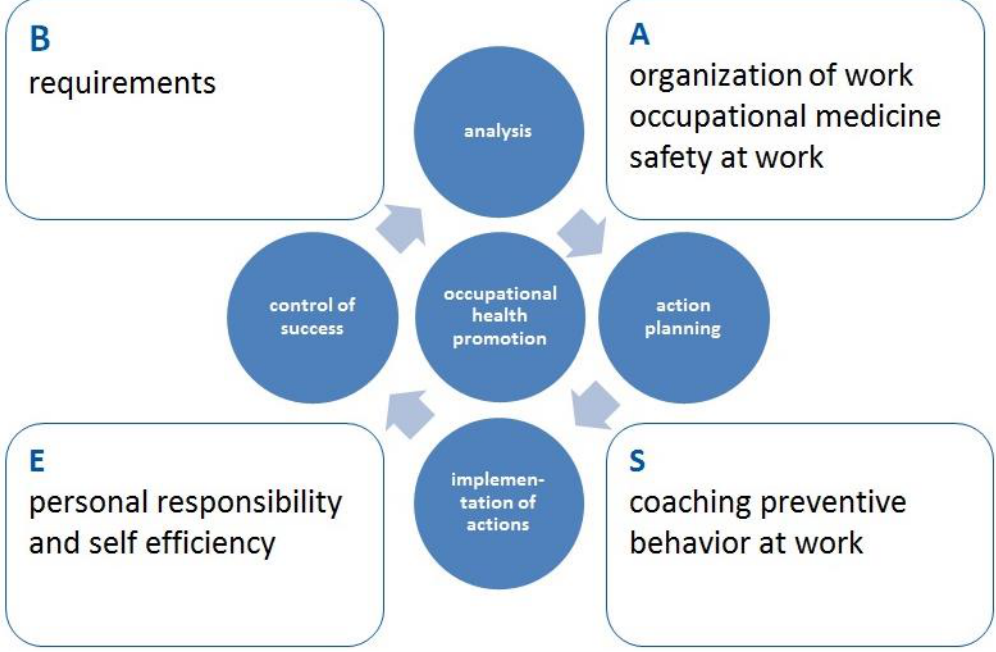
Figure 1. The basic structure of the BASE-program.